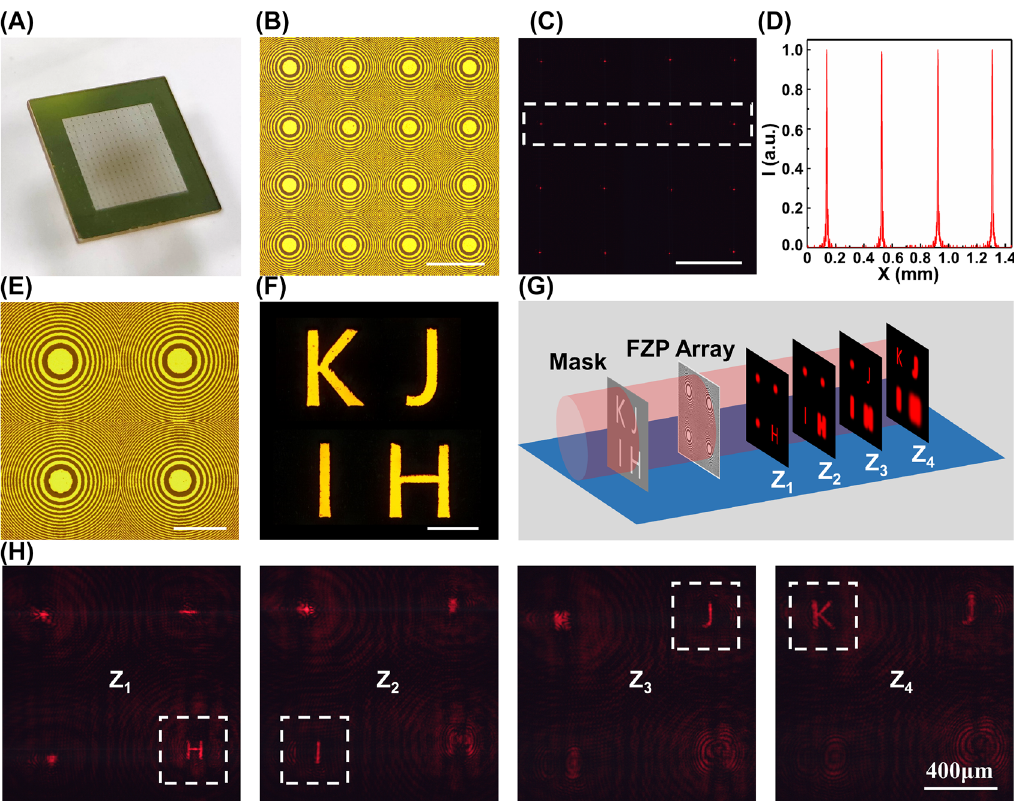
Figure 5: Fabrication of large-scale FZP arrays. (A) Photograph of a 16 × 16 square-arranged FZP array ( f = 4 mm) with an overall size of 6.48 × 6.48 mm. (B) Magnification microscopy image of a 4 × 4 array. (C) Corresponding measured intensity distribution of a 4 × 4 multifocal array. (D) normalized intensity profile plotted along the central cross section of the focal spots in the white dashed box. (E) microscopy image of a 2 × 2 FZP array consisting of four FZPs with a focal length of 12, 13, 14, and 15 mm, respectively. (F) Microscopy image of the laser-fabricated mask captured using transmittance mode. (G) imaging separation of the microletter hollow patterns on a mask using the 2 × 2 FZP array. (H) Captured images at different focal planes of the FZP array. The white dashed boxes indicate the corresponding imaged